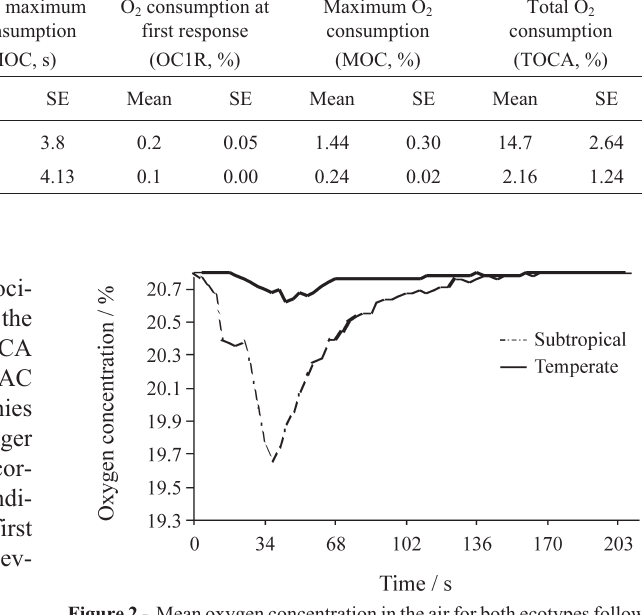
Figure 2 - Mean oxygen concentration in the air for both ecotypes follow- ing exposure to